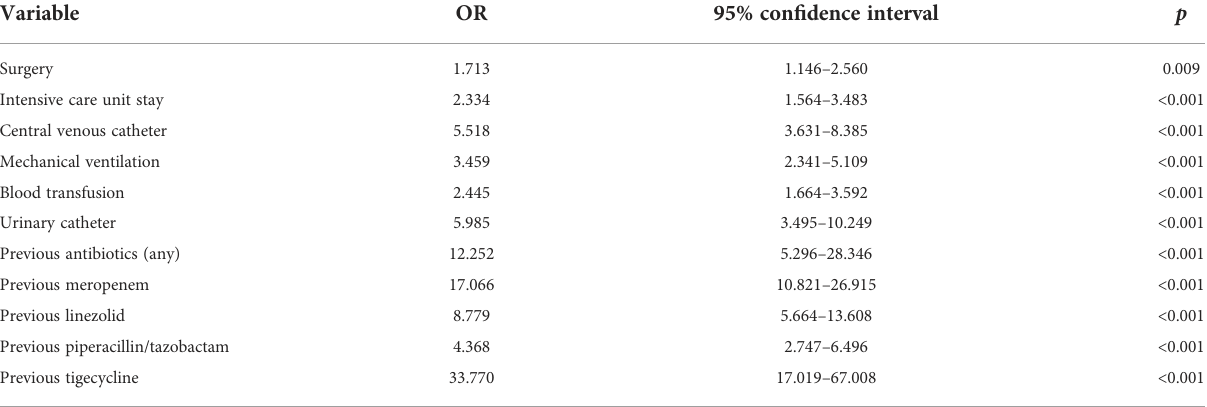
TABLE 4 Multivariate analysis of risk factors associated with Klebsiella pneumoniae NDM-1 infection. Variable